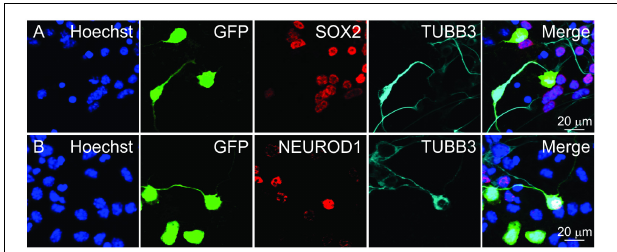
FIGURE 4 | Identifying cells for fluorescence intensity and neurite length measurements. GFP+ cells marked after transfecting a GFP overexpression plasmid. GFP+ cells were categorized based on TUBB3 expression. Individual cells were selected and ordered in pseudotime. Selected cells were then used for measuring nuclear (A) SOX2 and (B) NEUROD1 fluorescence intensities. Scale bars as noted.